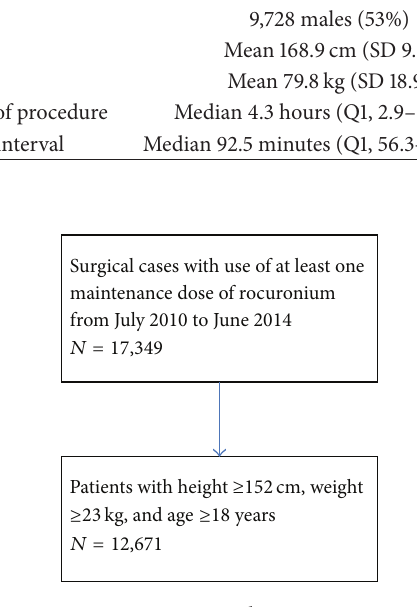
Figure 1: Patient inclusion